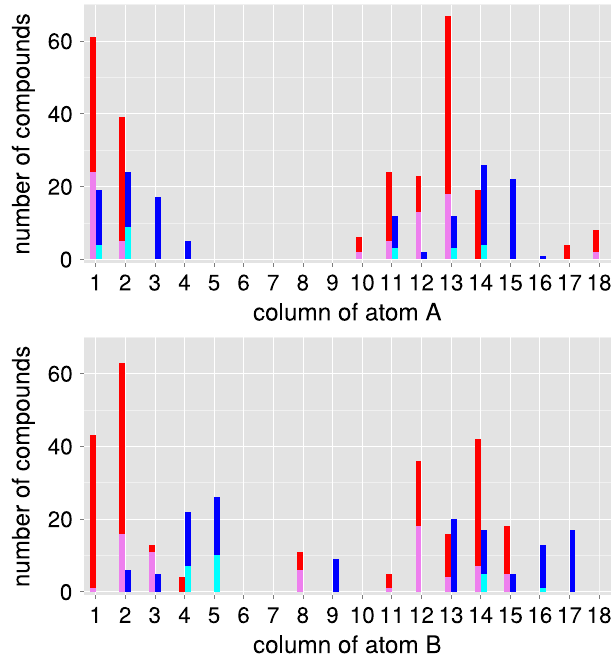
FIG. 5. Column number of the element at site A (top) and B (bottom) of the perovskite ABX 3 in the initial list of fluoride (red) and oxide (blue) paramagnetic semiconductors and after screen- ing for mechanical stability (violet and cyan, respectively).